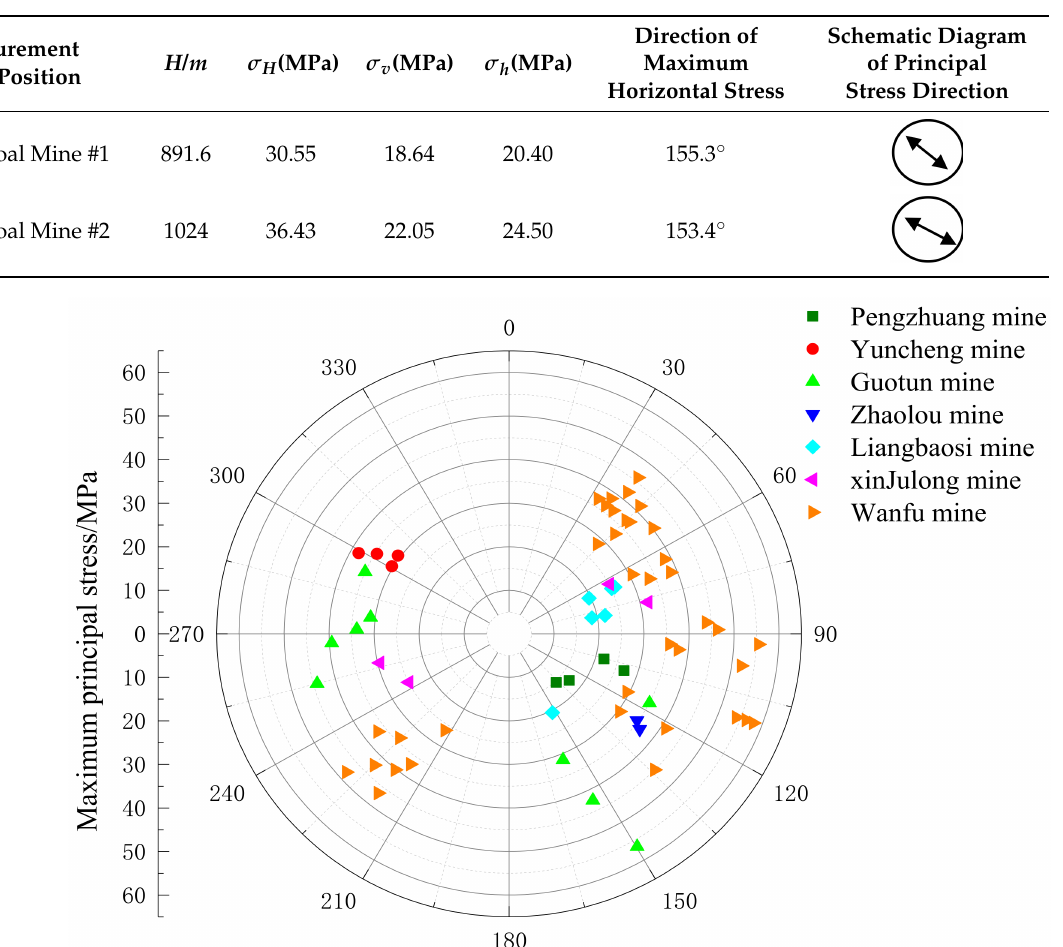
Figure 3. General distribution of principal stress.